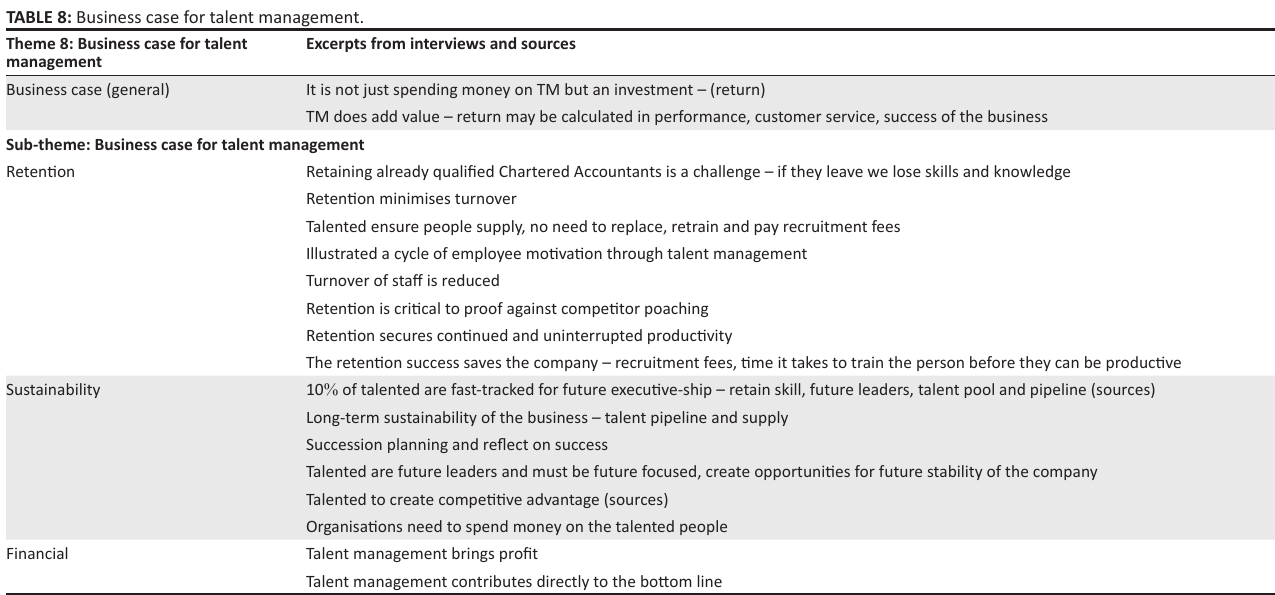
Table 8 continues on the next page